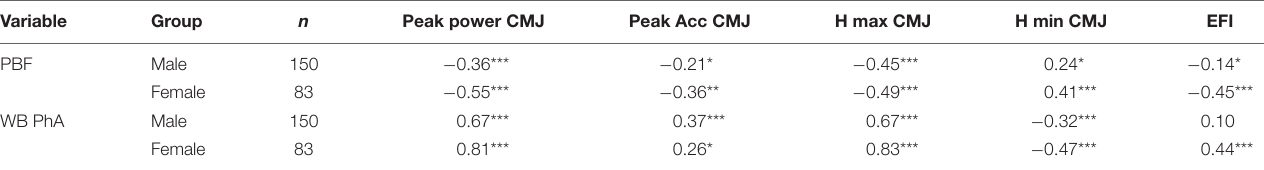
Female 83 0 . 81 *** Acc, acceleration; CMJ, countermovement jump; H, height; EFI, Esslingen fitness index; PBF, percent body fat; WB PhA, whole body phase angle. *P < 0.05, **P < 0.001, ***P < 0.0001.